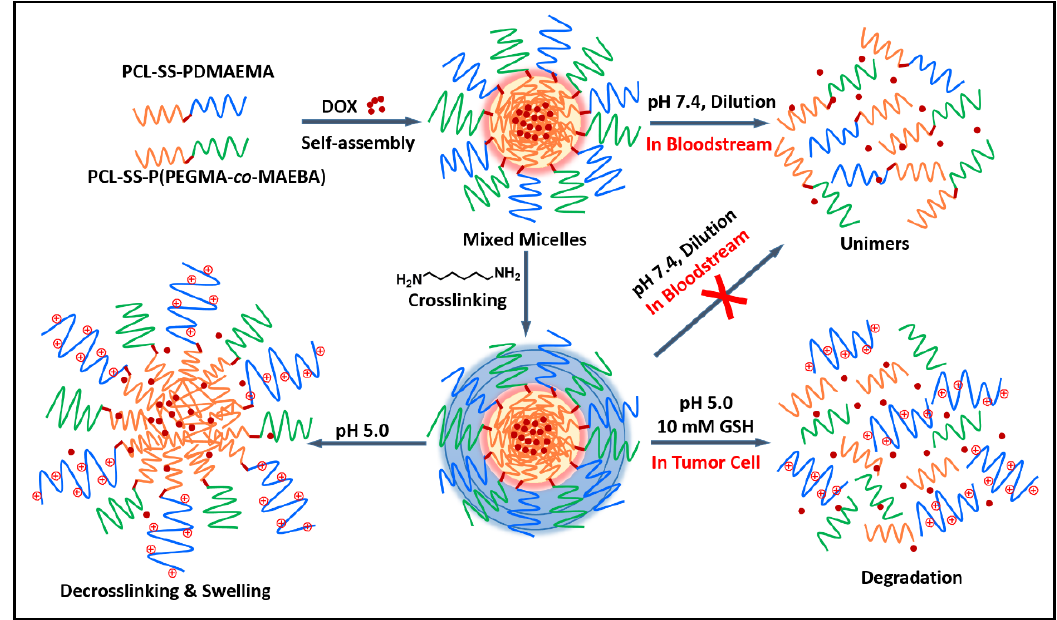
Scheme 1. Schematic illustration for reversible cross-linked mixed micelles and the pH/redox- triggered controlled drug release.